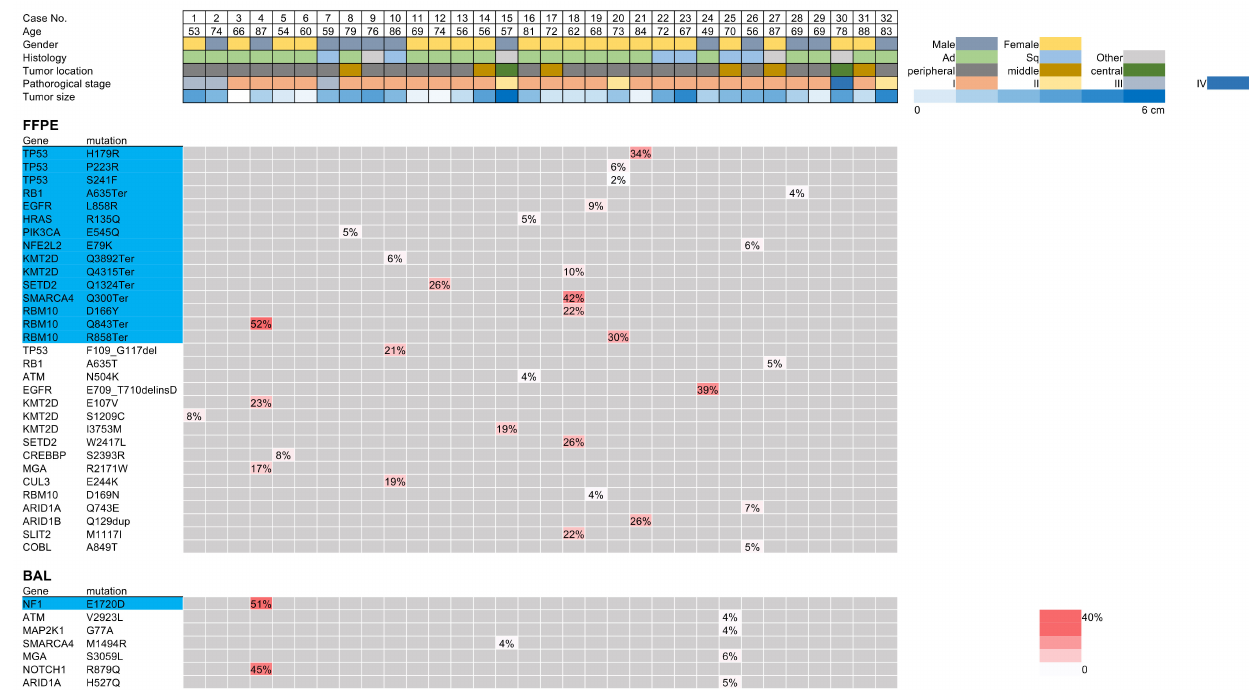
Figure 4. Discordant mutations between the ex vivo bronchoalveolar lavage (BAL) fluid and lung cancer tissues. The discordant mutations are shown with the allele fractions visualized on the heatmap. The upper rows show mutations detected only in the FFPE sample and the lower rows show mutations detected only in the BAL fluid. The gene mutations highlighted in light blue are